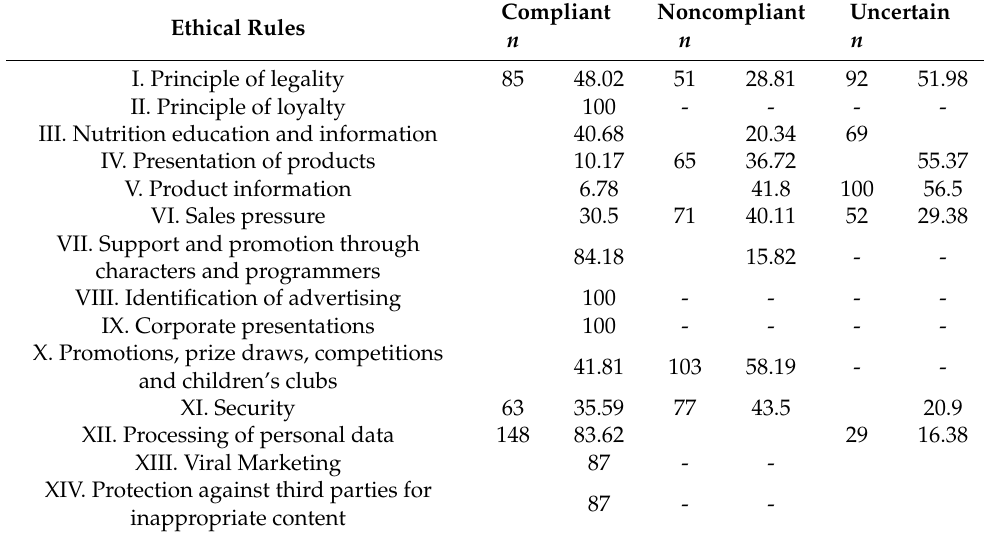
Table 2. Compliance with the Drink Advertising Code for Children (PAOS Code) and its ethical rules in Spain,